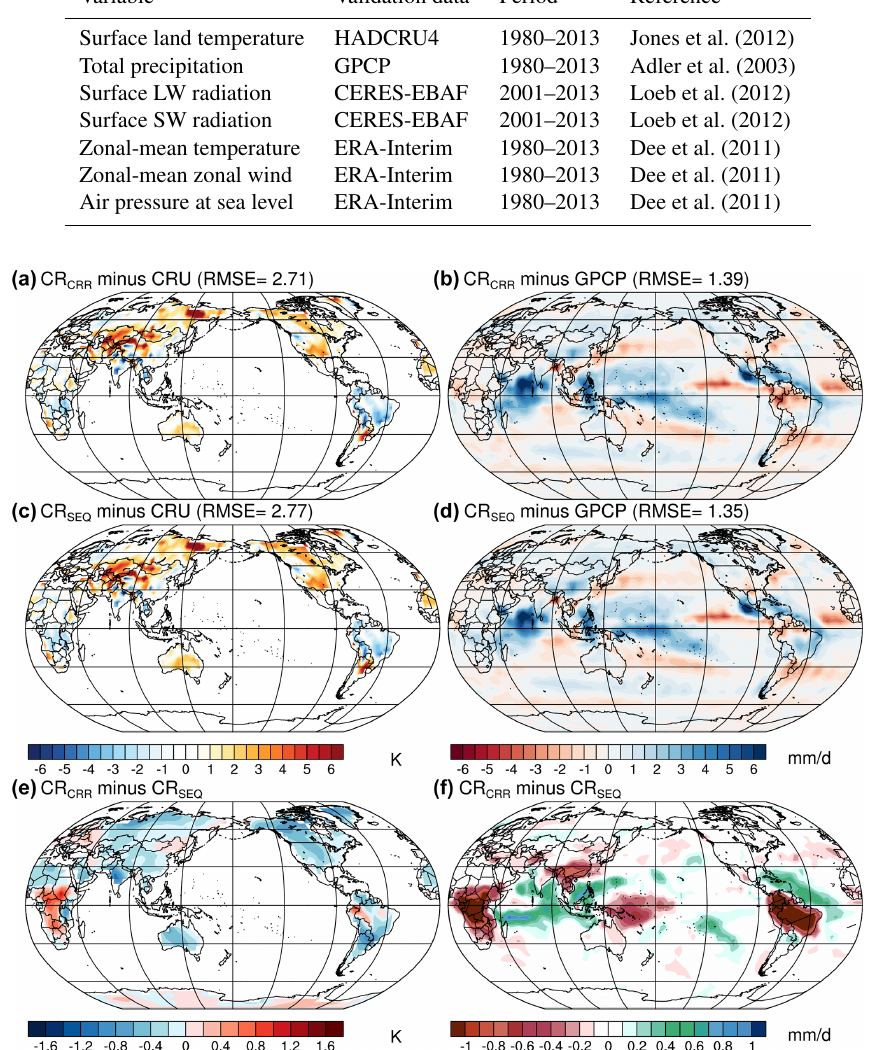
Figure 14. Annual bias in surface air temperature (SAT) over land (K) and total precipitation (mmd − 1 ) in the (a, b) concurrent and (c, d) clas- sical radiation experiments relative to the Climatic Research Unit time series 4.01 data set (CRU TS; Harris et al., 2014) and the Global Precipitation Climatology Project data set v2.3 (GPCP; Adler et al., 2003) for the period 1980–2013, respectively. Differences in the (e) SAT over land and (f) total precipitation between the concurrent and classical radiation scheme for the period 1980–2013. Hatching indicates significance at the 95% confidence interval using the Student’s t